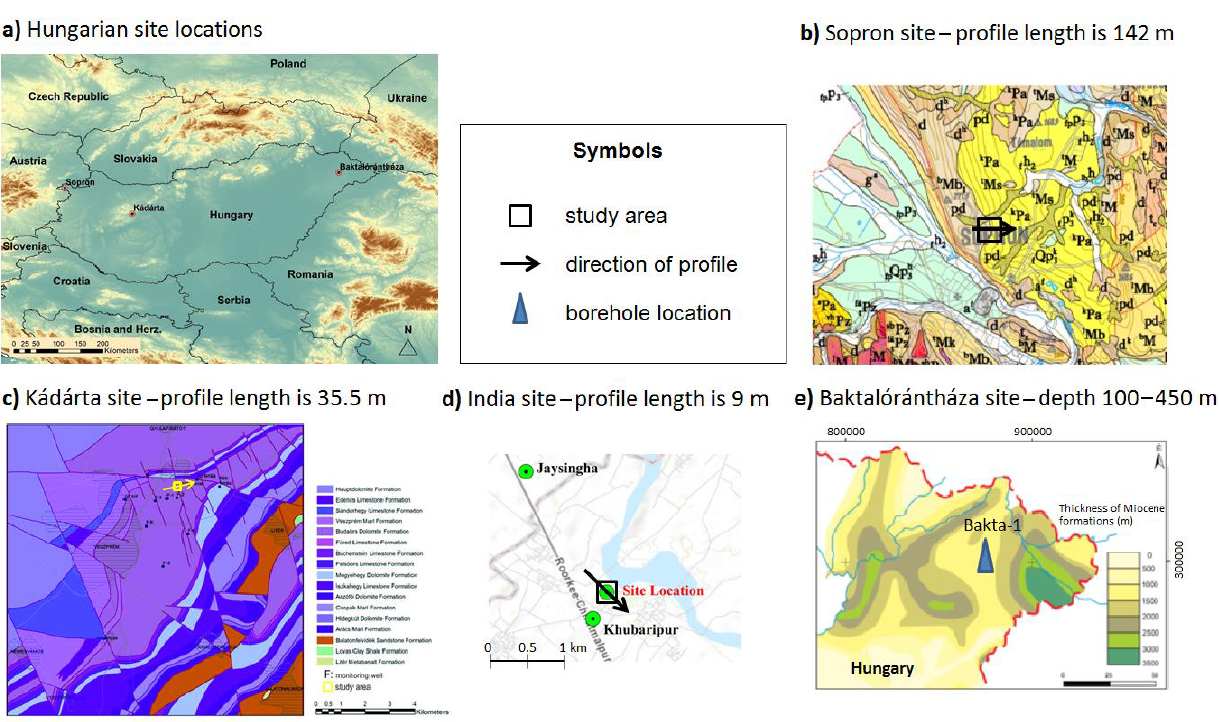
Figure 3. Overview of the study areas investigated by the proposed hydrogeophysical methods: ( a ) locations of the Hungarian sites; ( b ) Sopron area, Hungary (Section 3.1.1); ( c ) Kádárta area, Hungary (Section 3.1.2); ( d ) Khubaripur area, India (Section 3.1.3); ( e ) Baktalórántháza area, Hungary (Section 3.2).